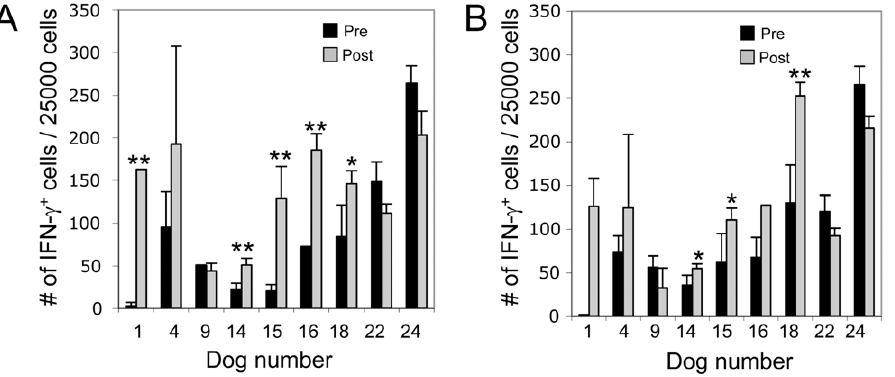
Figure 4. RNA loaded CD40-B cells stimulate antigen-specific IFN- c responses in PBMCs. PBMCs were obtained from dogs at the time of diagnosis (pre) and 3 weeks post vaccination (post) and antigen-specific immune responses directed against (A) CDV-HA and (B) lymph node tumor antigens were determined by IFN- c ELISPOT. *p , 0.1, **p , 0.05.